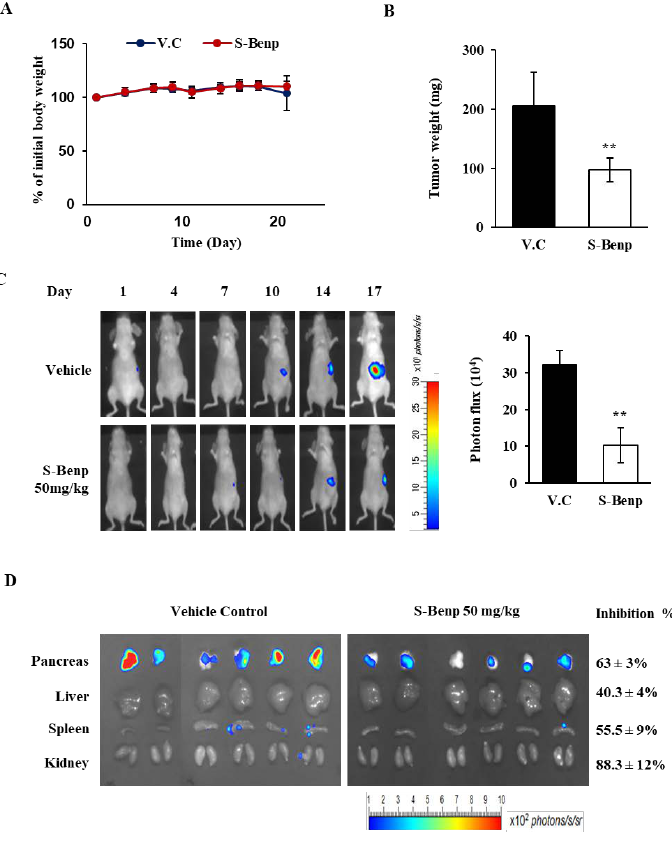
Figure 3. Inhibition of pancreatic cancer metastasis by S-Benp. ( A ) Change in body weight of vehicle- or S-Benp-treated mice over 21 days. ( B ) Reduction in tumor growth by S-Benp in a mouse model. ( C ) Representative images from luciferase-expressing AsPC-1 cells in the whole body. ( D ) Visualization of bioluminescence in the pancreas, liver, spleen, and kidney by luciferase-expressing AsPC-1 cells. The color scale indicates radiance (× 10 2 photons/s/sr). The data represent means ± s.d.; ** p < 0.01.